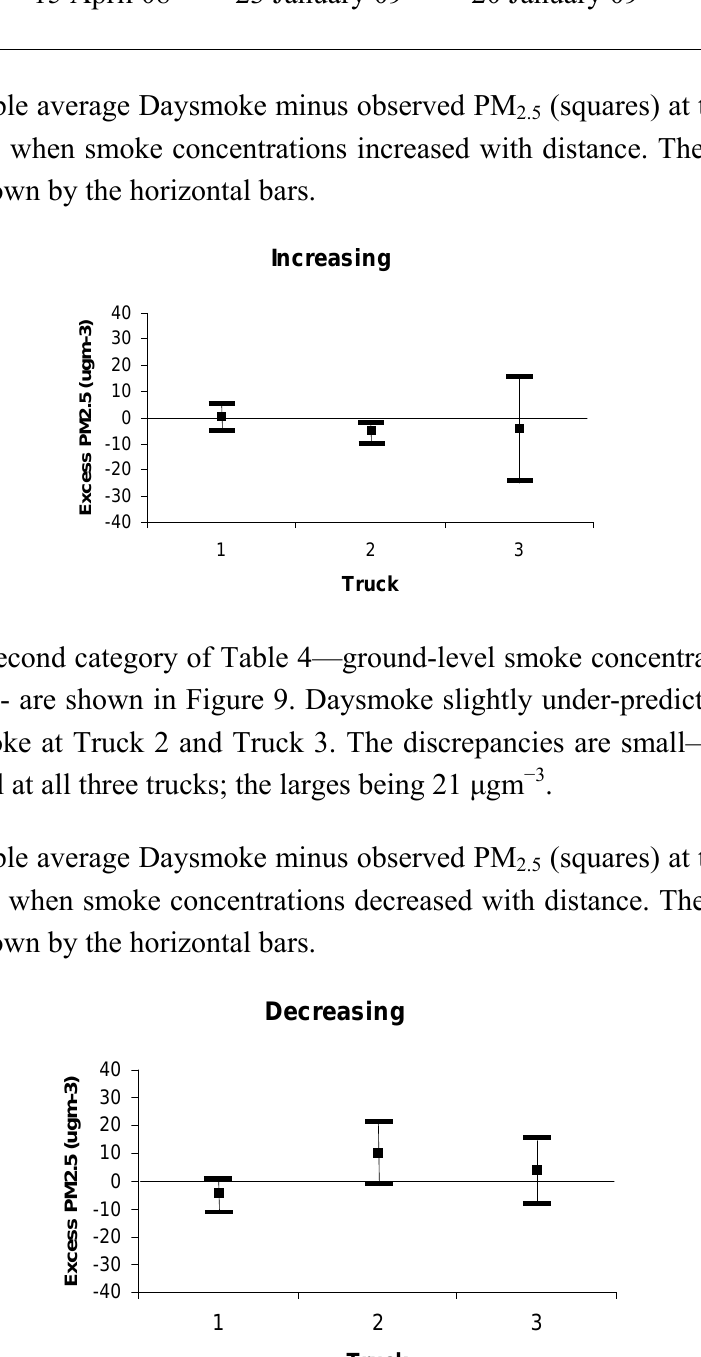
(squares) at the three trucks 2.5